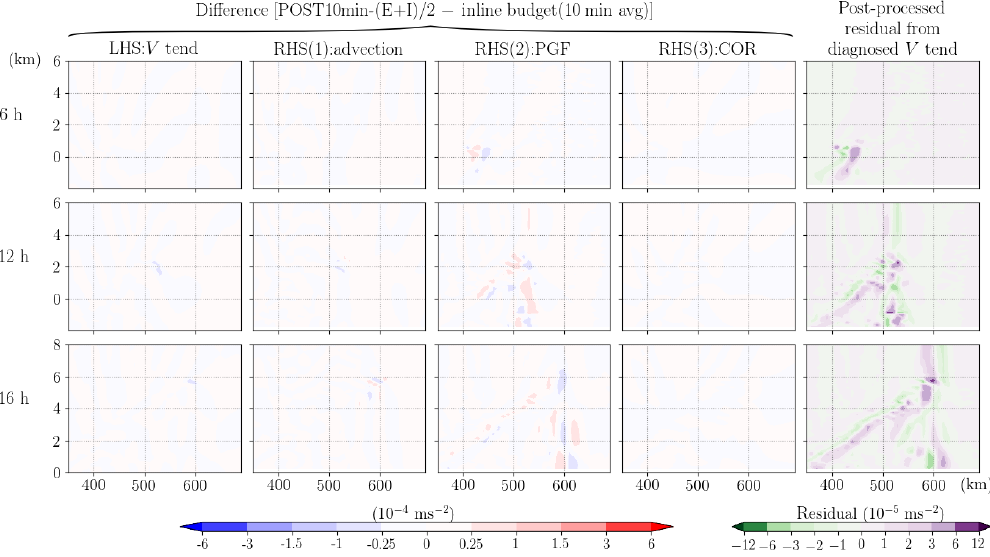
Figure 11. Same as Fig. 8, but the forcing terms diagnosed in the post-processed budget analysis are the averages of explicit and implicit methods (POST10min-(E+I)/2). To represent the same time window as the post-processed analysis, the inline budget results used here for the difference calculation are the 10min averages (corresponding to the output interval) instead of the instantaneous